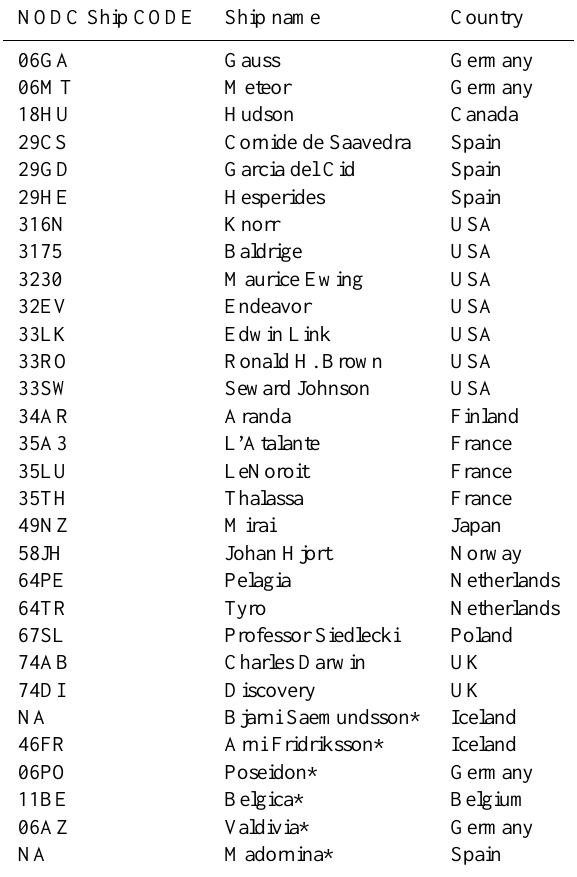
Table 2. List of ships that contribute to the CARINA Atlantic data set. Ships with an * symbol are included in the CARINA-ATL data set under the entry “OMEX1NA”, NA denotes unknown EX-